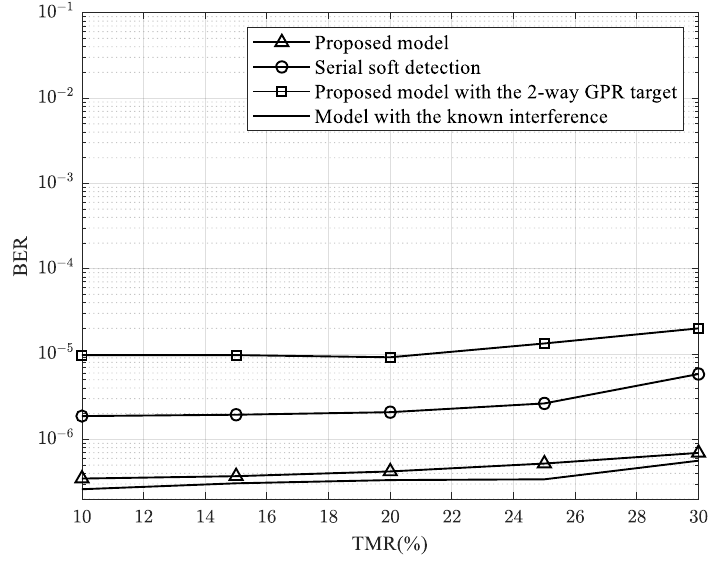
Figure 11. BER vs. TMR with SNR = 15 dB.